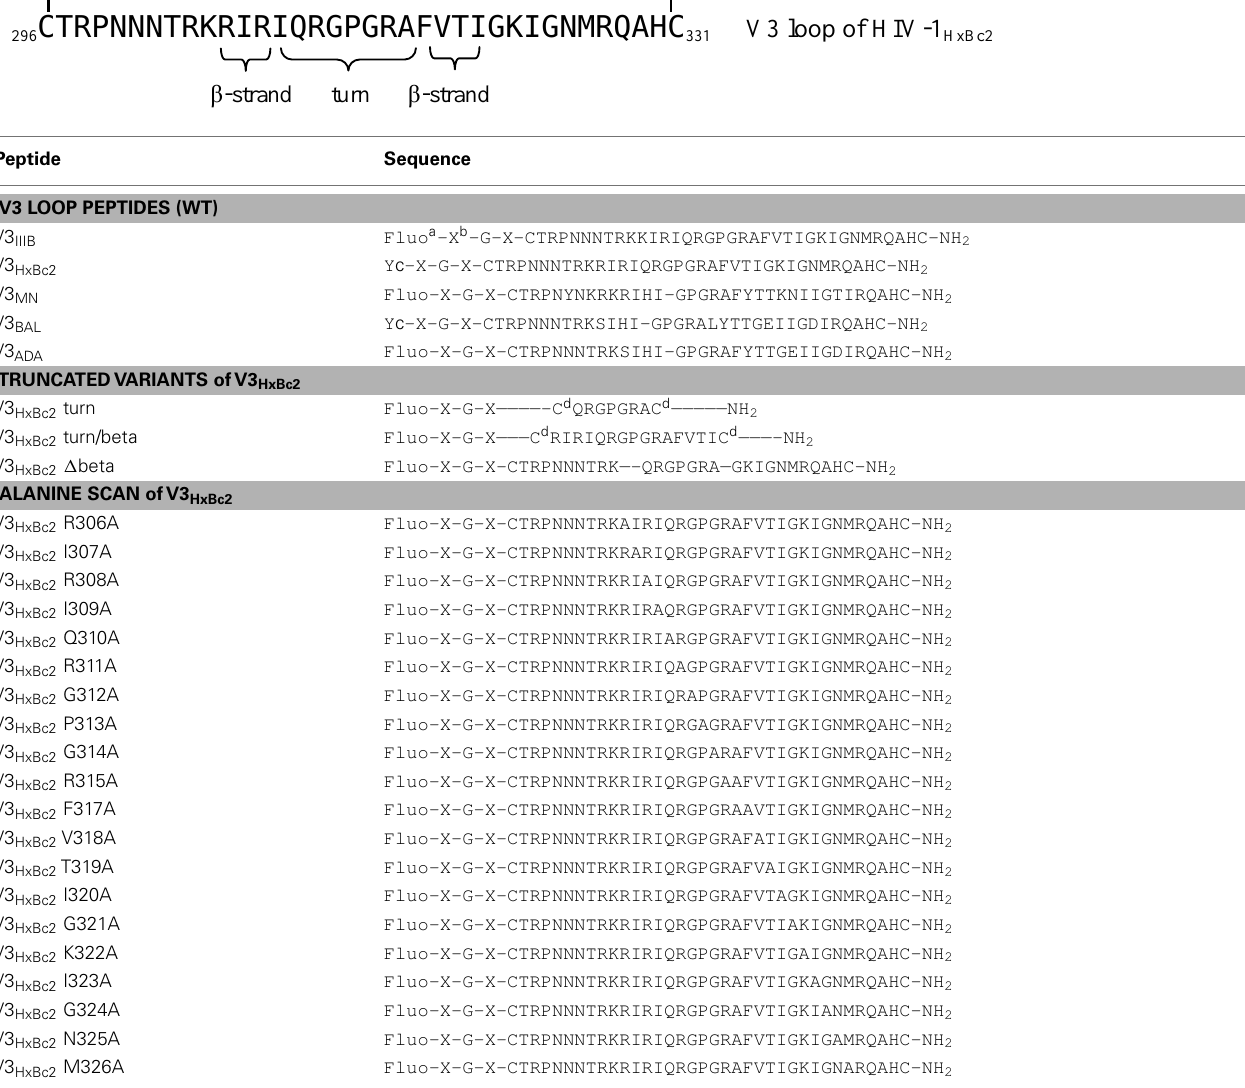
Table 3 | Sequences ofV3 loop peptides. Table 3. Sequences of V3 loop